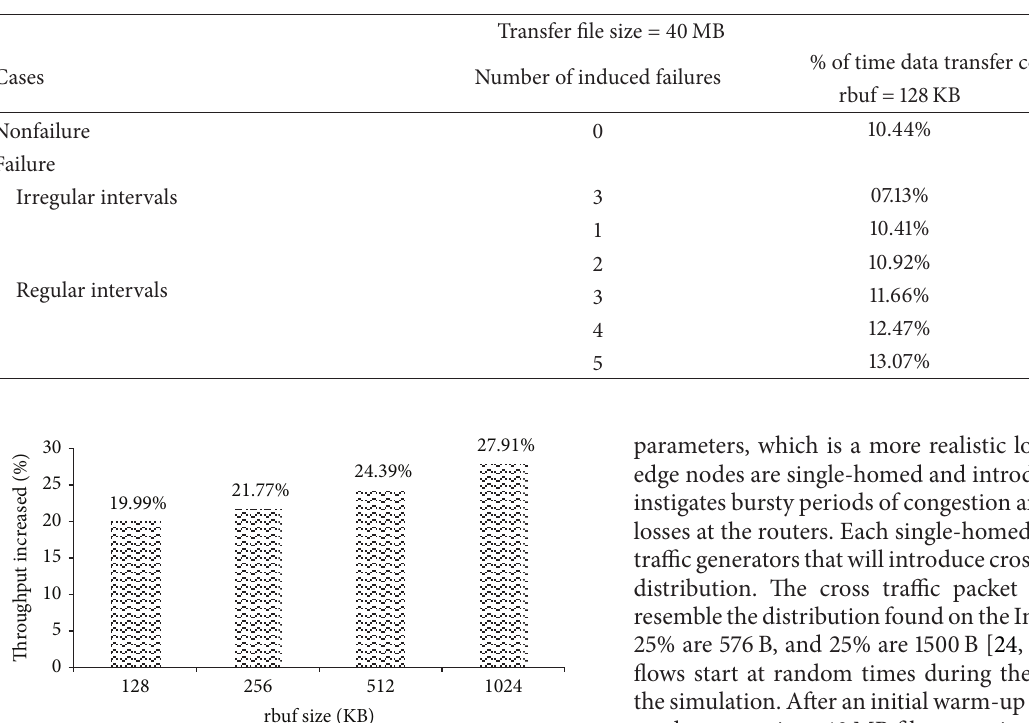
Table 4: Overall analysis during failure and nonfailure scenarios.